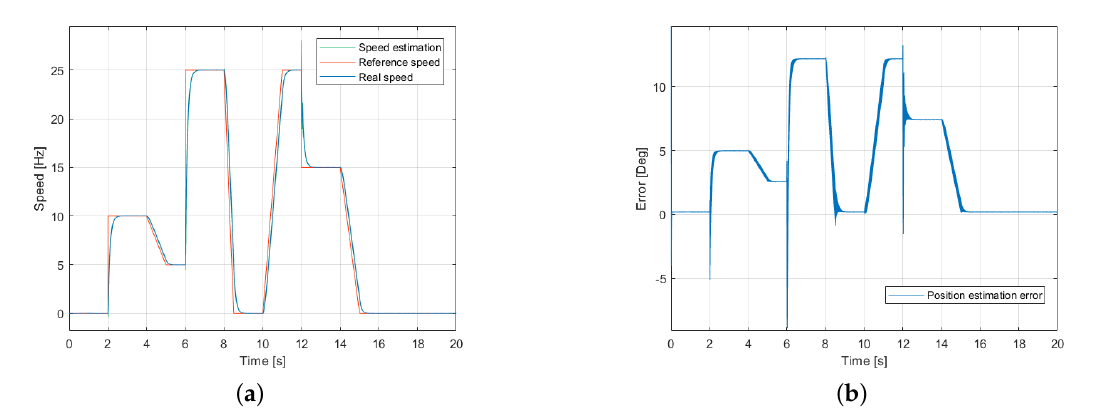
Figure 8. Saliency-based estimator simulation. ( a ) Speed profile. ( b ) Position estimation error.